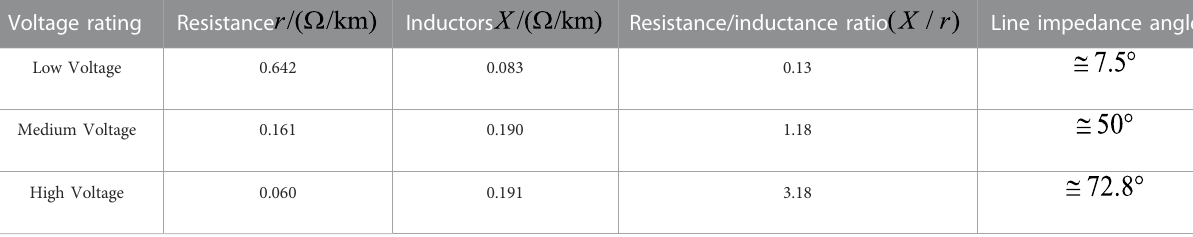
TABLE 1 Comparison of line impedance characteristics at different voltage levels.